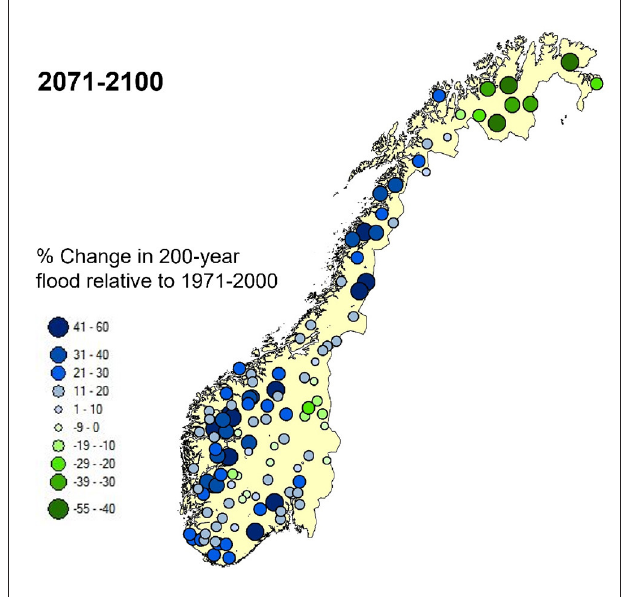
FIGURE 3 | Percentage change in the 200-year flood between the reference period 1971–2000 and projection period 2071–2100 for RCP8.5. The estimates are based on the ensemble median of 500 simulations for each of the two emission scenarios (RCP 4.5 og 8.5). For each of 115 catchments, 10 climate models (see Table 2 ) have been downscaled and bias-adjusted using two methods. In addition, the 25 best parameter sets calibrated for each catchment were used in successive runs of the hydrological model for that catchment (From Lawrence,